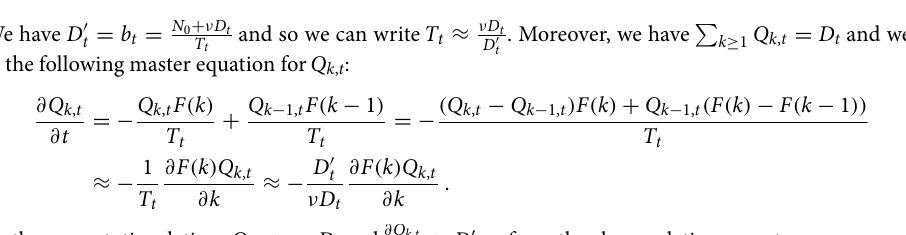
Figure 5. COVID-19: (Left) Frequency-rank plot with two different scales: log-sqrt before a certain R log after R . Parameters (see Sects. 3.3.1 and 3.4 for details): a 1 ∗ give